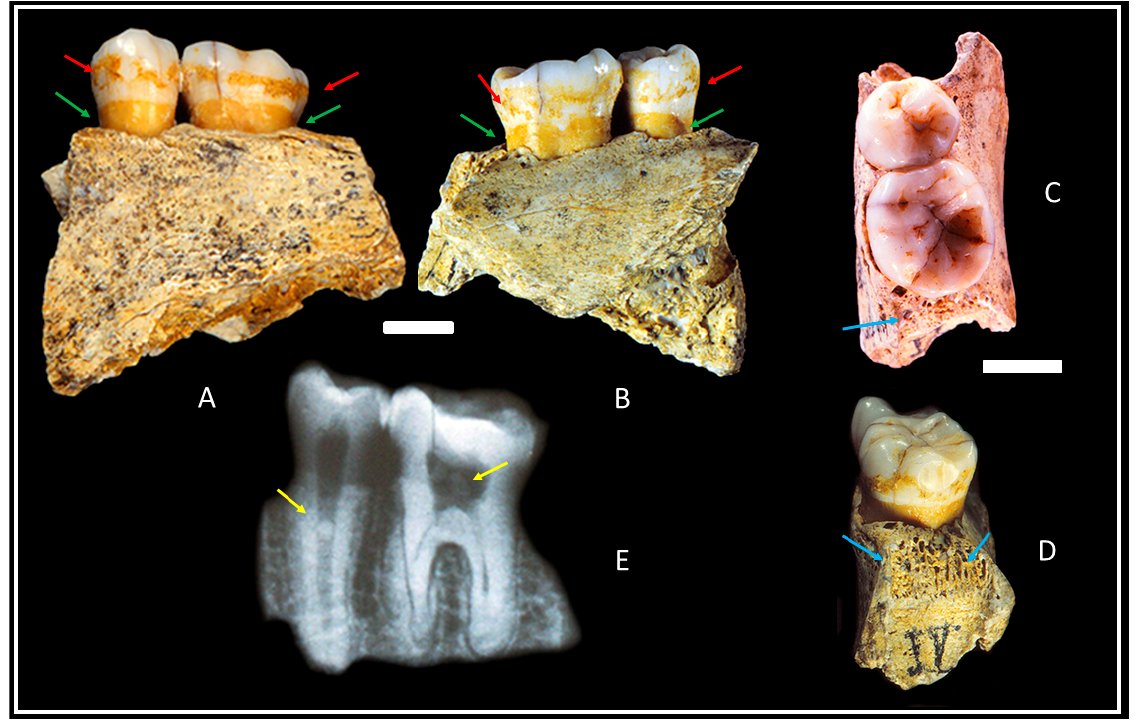
Figure 1. Combe-Grenal IV: external ( A ), internal ( B ), occlusal ( C ), distal side of the LLM1and the alveolus of the LLM2 ( D ), X-ray ( E ) external side. Scales = 10 mm